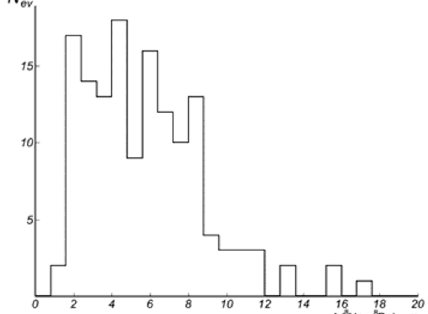
Figure 4. Distribution of distances L( 8 Не – 8 Be) between points of stops of 8 Не and vertices of decays 8 Be (2 + ) in “broken”